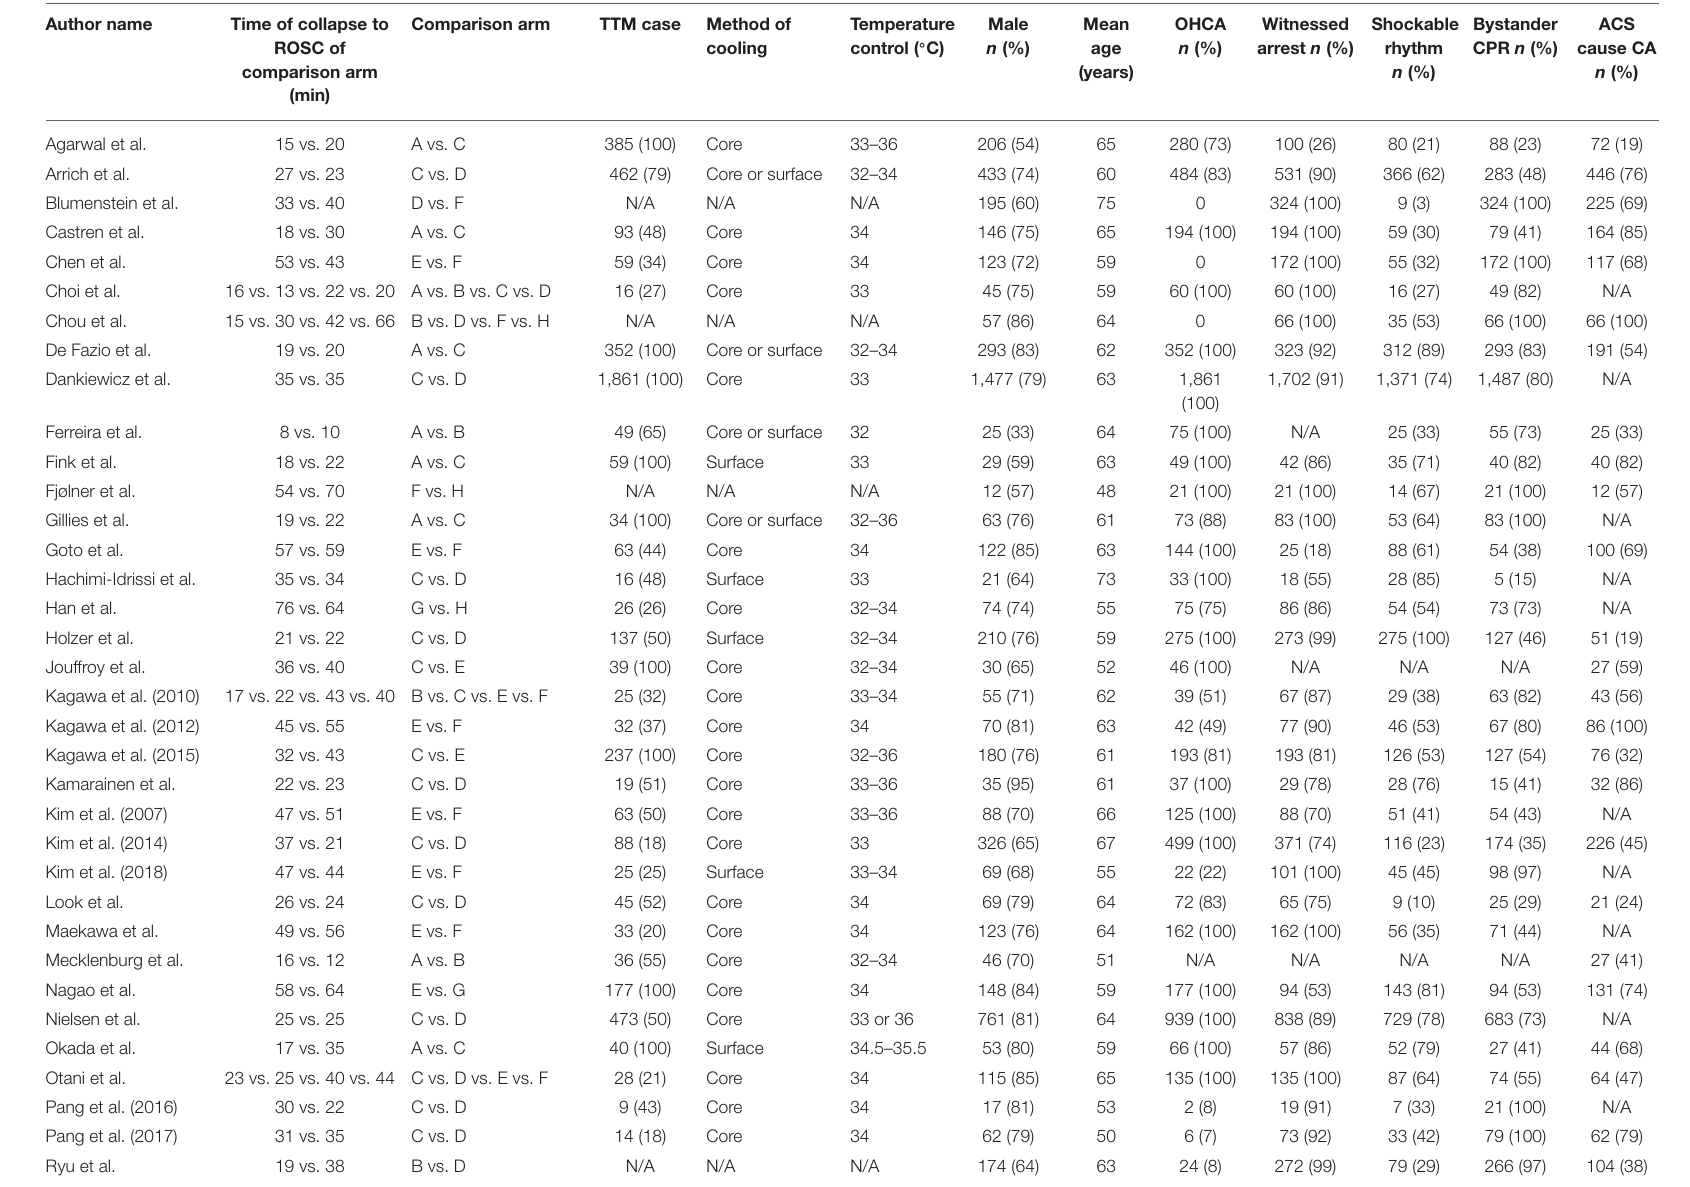
TABLE 2 | Characteristics of comparison arms (A: < 20min + TTM; B: < 20min; C: 20–39min + TTM; D: 20–39min + TTM; E: 20–39min; F: 40–59min + TTM; G: ≥ 60min + TTM; H: ≥